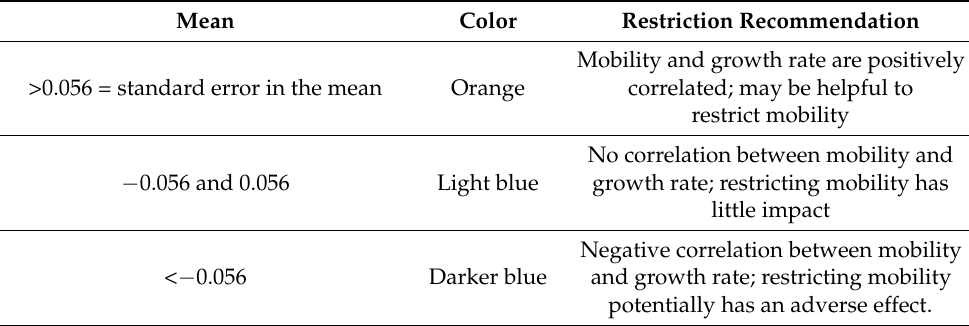
Table 3. Correlation Mean